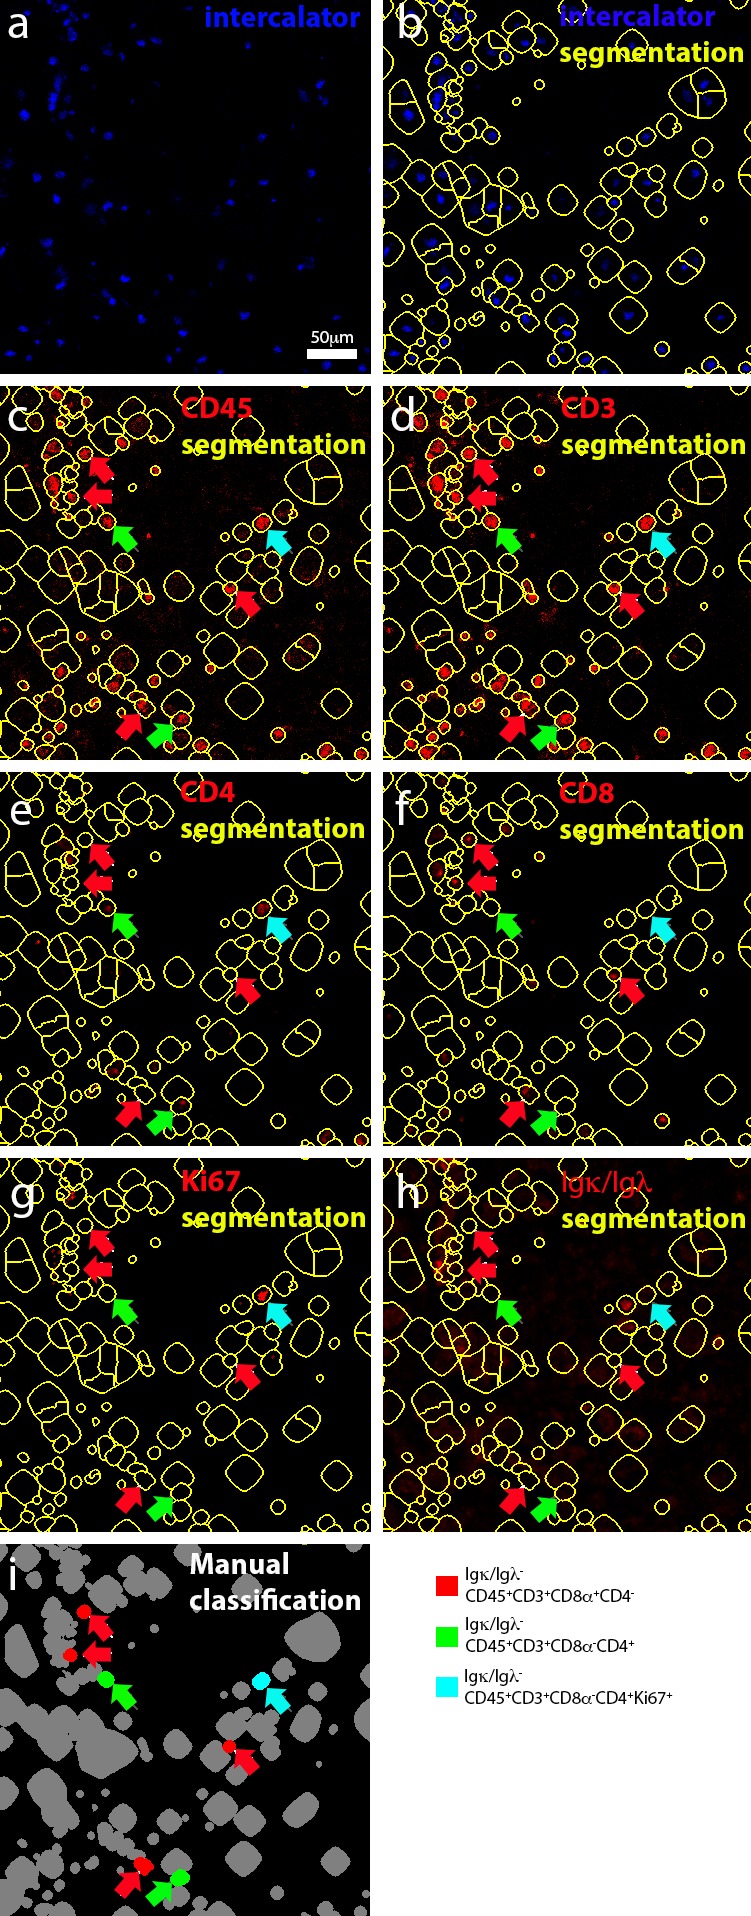
Manual selection of T cells.(a) Representation of manually-annotated cells in an active lesion, based on the detection of nuclei. (b) Segmented cells. (c–h) Identification of cells that express (for example CD45+CD3+CD4+ or CD8+) or do not express (for example Igκ/Igλ-) a biologically relevant set of markers. (i) Classification of T cells. Red arrows were used throughout (c–i) to track CD8+ T cells. Green arrows were used throughout c–i) to track CD4+ T cells. Cyan arrows were used throughout (c–i) to track CD4+ proliferating T cells.